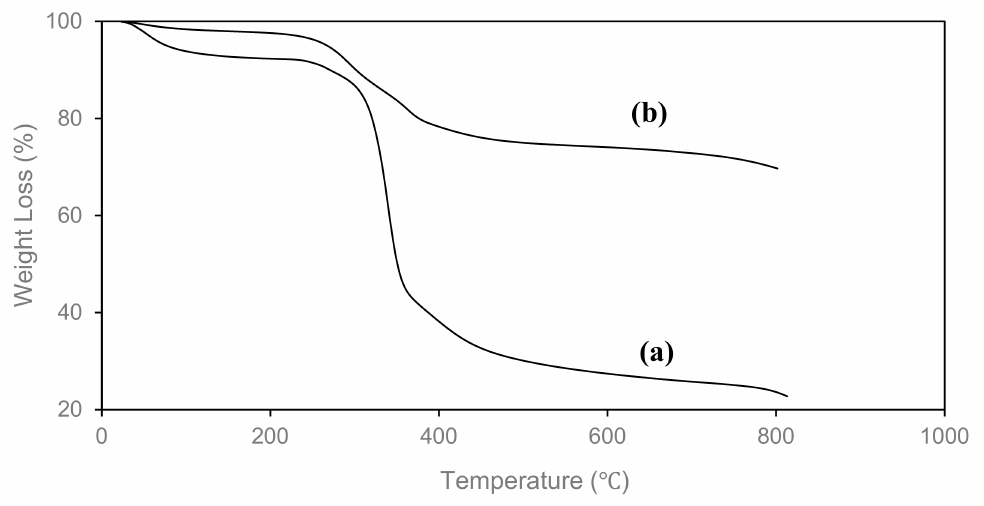
Figure 8. TGA analysis of ( a ) OPEFB-CNF and ( b )